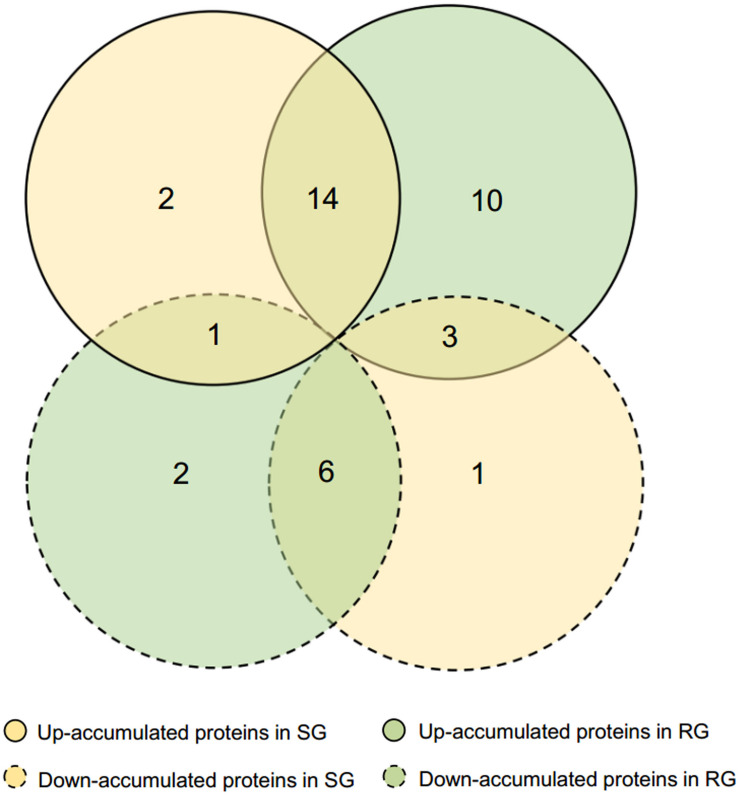
Venn diagram of differentially accumulated proteins (DAPs) in RG and SG infected with FON. DAPs were analyzed based on SG-FON vs. SG-C and RG-FON vs. RG-C libraries, respectively.